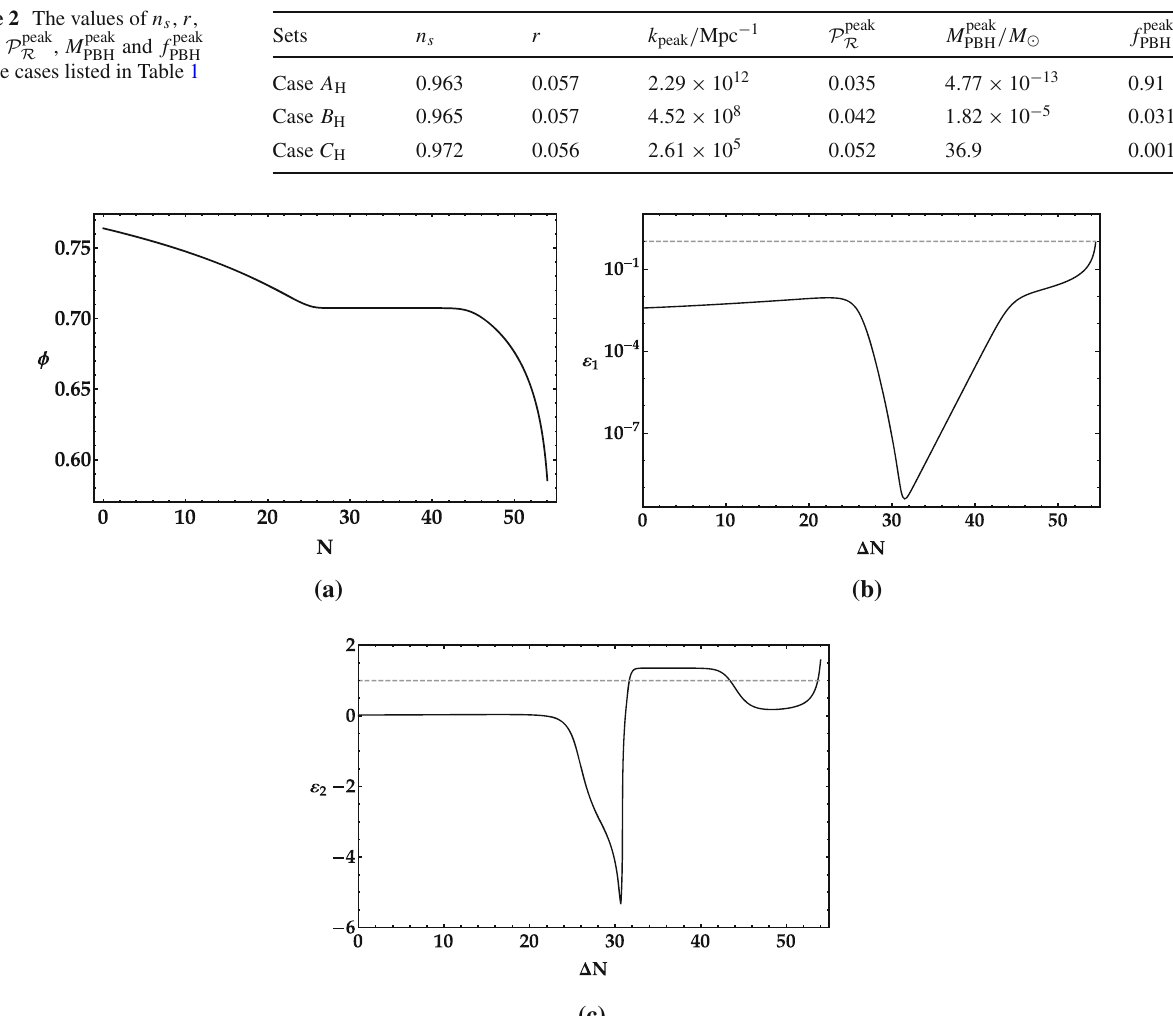
Fig. 1 Evolutions of a the scalar filed φ , b the first slow-roll parameter ε 1 and c the second slow-roll parameter N for the quartic inflation model. The dashed line shows the violation